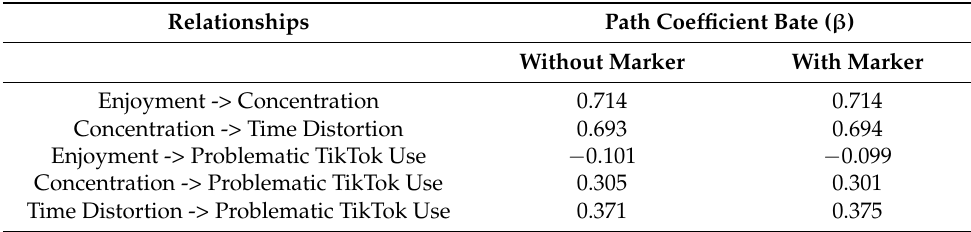
Table 3. Comparison of Path coefficient ( β ) between the baseline model and markerincluded model.